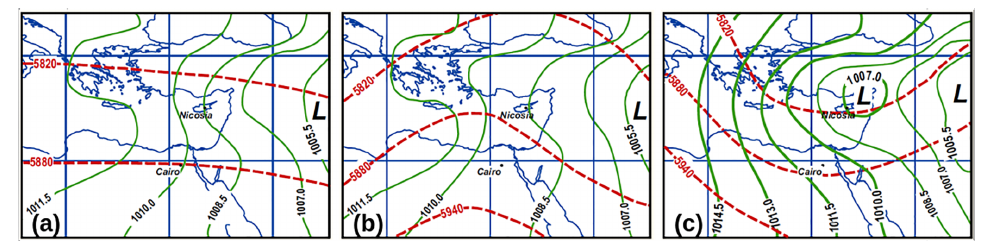
Figure 10. Typical synoptic charts showing the three modes: (a) moderate, (b) shallow, and (c) deep modes of the Persian Trough as defined by the surface-pressure differences between Nicosia (Cyprus) and Cairo (Egypt), and their associated upper-level conditions. Solid lines are isobars of sea-level pressure with 1.5hPa intervals. Dashed lines are contours at 500hPa level with 60m intervals (from Dayan et al., 2002; ©American Meteorological Society; used with